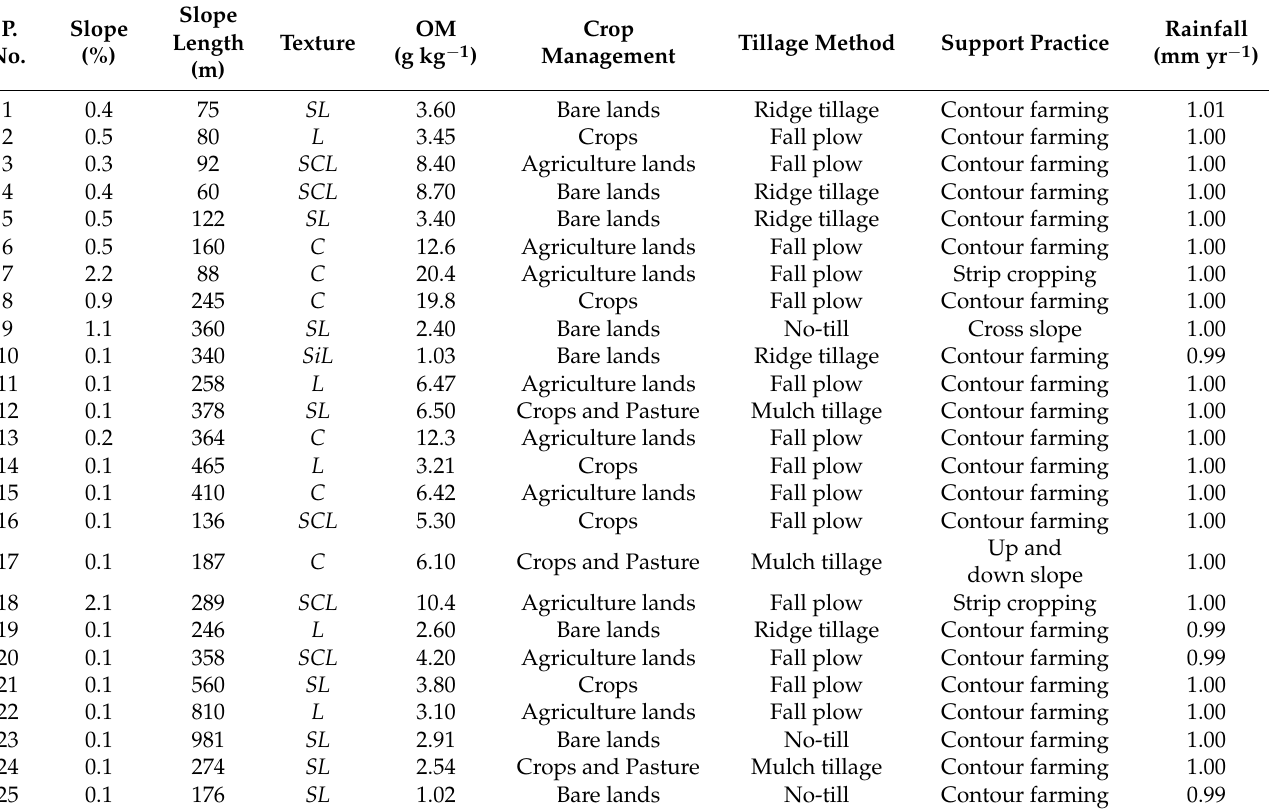
Table 10. Land properties of the investigated